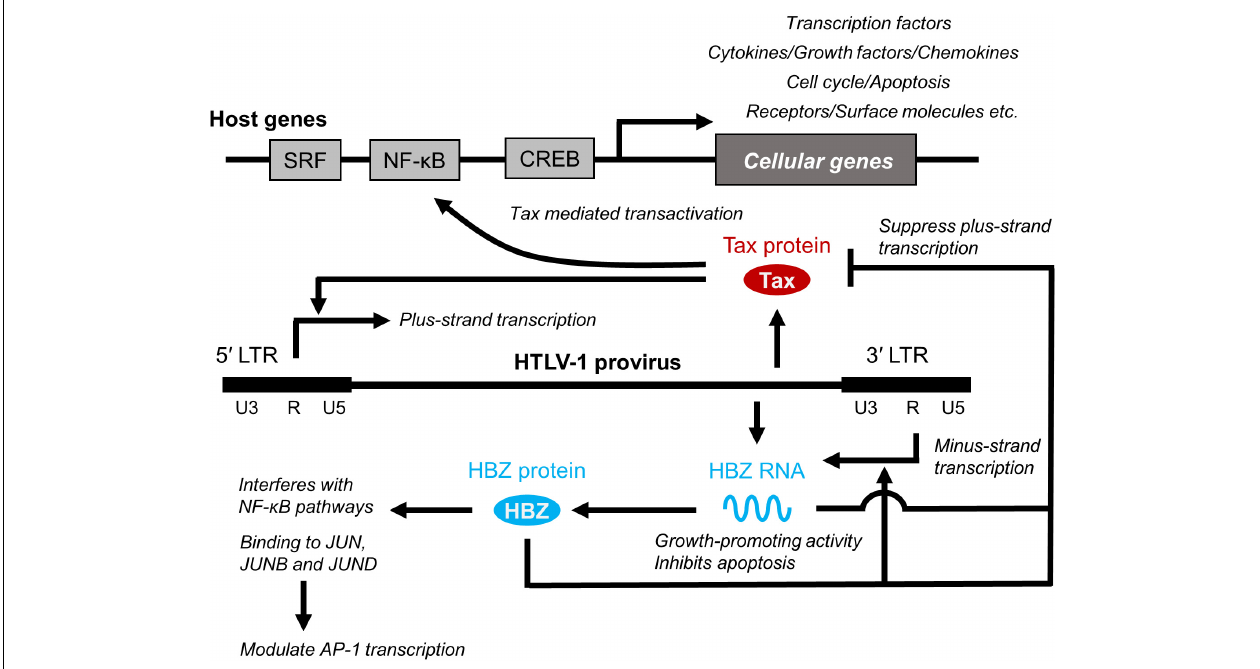
FIGURE 2 | Role of Tax and HBZ. Two viral genes, Tax and HTLV-1 bZIP factor (HBZ) play critical roles in viral transcription and promotion of T-cell proliferation by interacting cellular factors, which is closely related to the long-term survival and persistence of HTLV-1 in infected individuals and development of HTLV-1-associated diseases. SRF, serum response